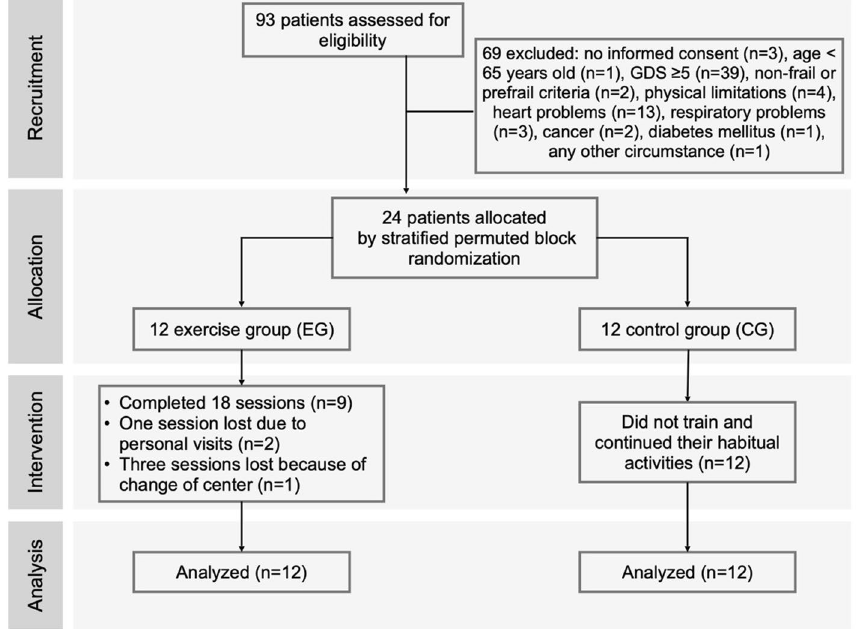
Figure 3. Consort flow chart for the selection and allocation of participants in the exercise and control